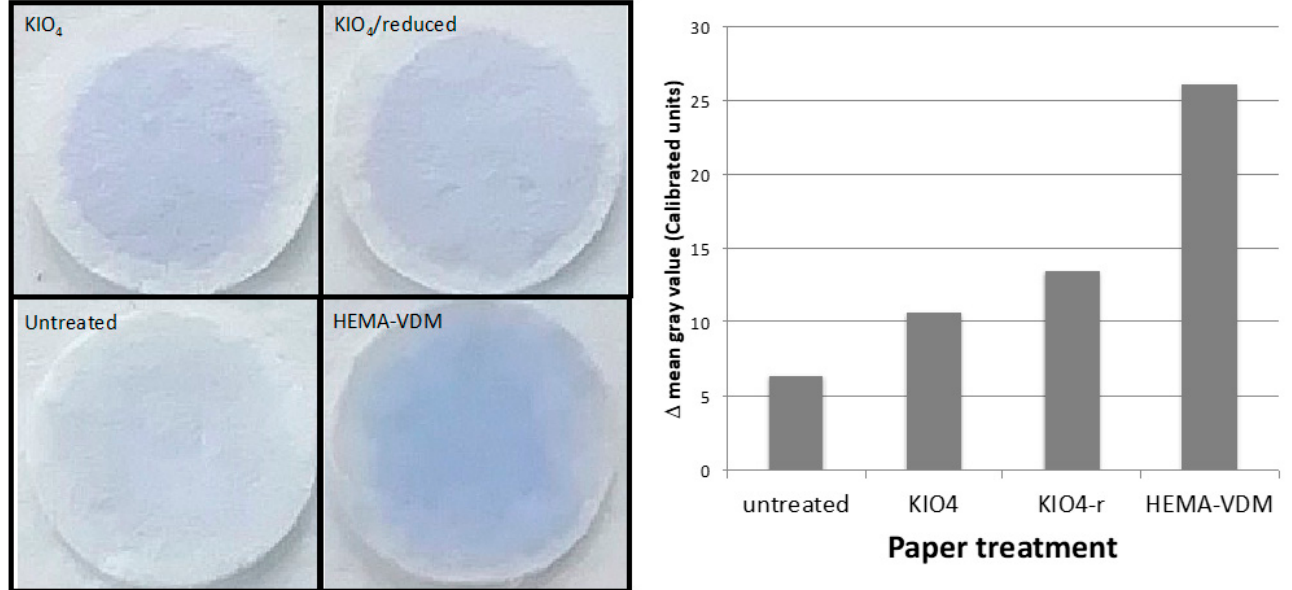
Figure 3. ( Left ) Representative stained discs after protein (BSA) immobilization on paper that was KIO 4 functionalized, KIO 4 functionalized and reduced, untreated or HEMA-VDM functionalized. Wash: three times with 10 mM HCl. ( Right ) Mean gray value of the discs in the pictures on the left.